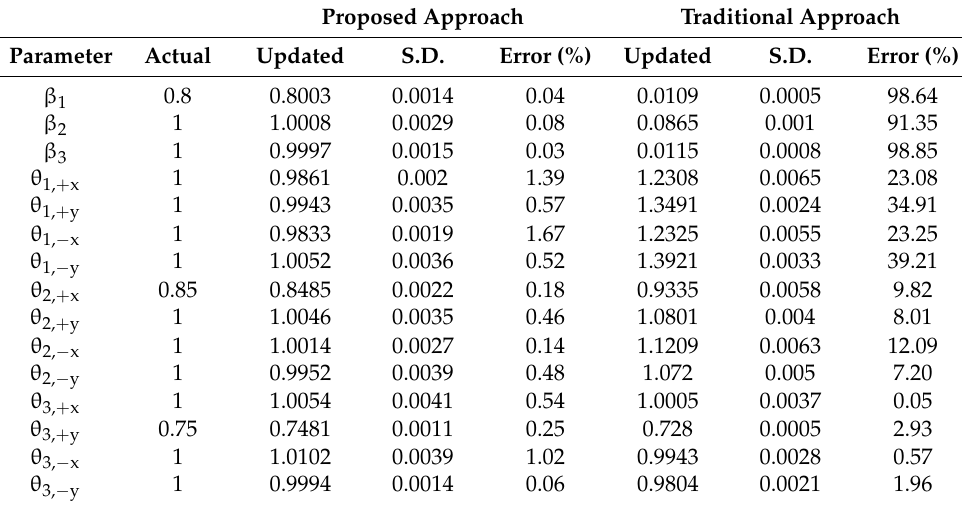
Table 11, the mass parameter and the stiffness parameter, β 3 and θ 3, − y , are updated as Table 10. Results of updated structural parameters for damage case No. 1.